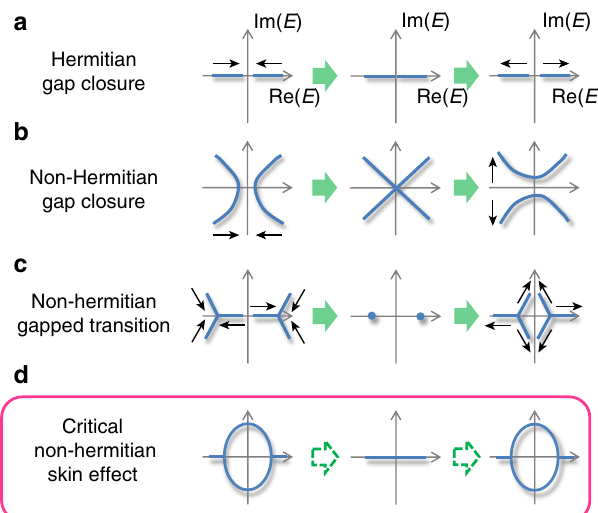
Fig. 1 Four different types of critical transitions. Hermitian phase transitions ( a ) are marked by gap closures along the real line. In non- Hermitian cases (2nd to 4th rows, axis labels omitted), spectral phase transitions can take more sophisticated possibilities in the 2D complex energy plane. For instance, the spectral topology can change under line gap closures ( b ) or shrink continuously to a point and re-emerge in a different topological con fi guration ( c ), without the gap ever closing 38 . The spectrum continuously passes through a gapless or point-like regime in the fi rst three cases, as indicated by the black arrows. The critical non-Hermitian skin effect ( d ), however, is special in that OBC spectrum in the thermodynamic limit, denoted E ∞ , jumps discontinuously from one con fi guration (left), to a different con fi guration (middle), and to another (right) as certain parameter changes from − ϵ to 0 (critical border), and to ϵ , for an arbitrarily small ϵ , without ever interpolating between the con fi gurations even though the parameter is continuously